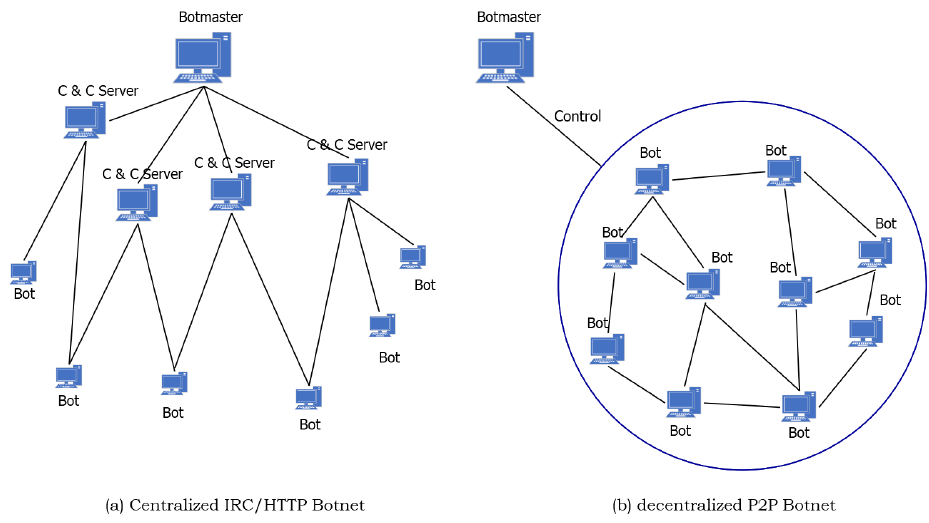
Figure 1. Difference between centralized and decentralized P2P